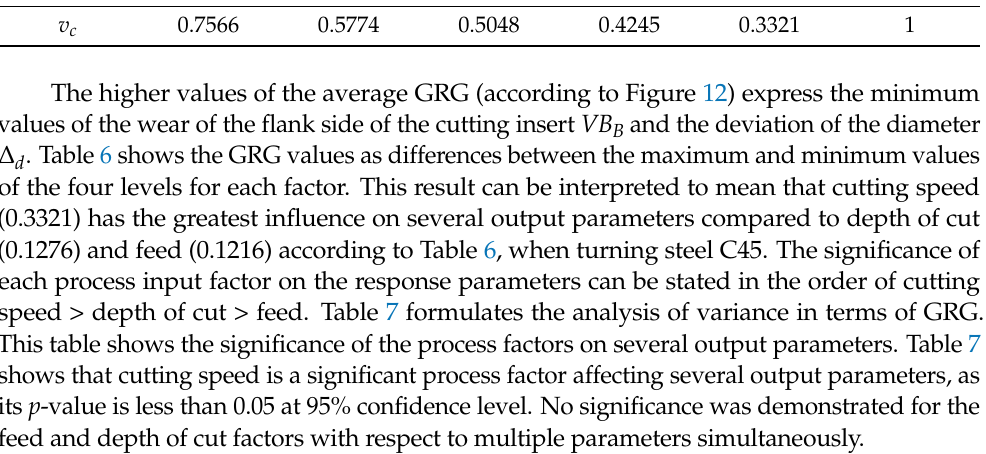
Table 6. Main effect on mean grey relational grade (total mean 0.5677). Factors